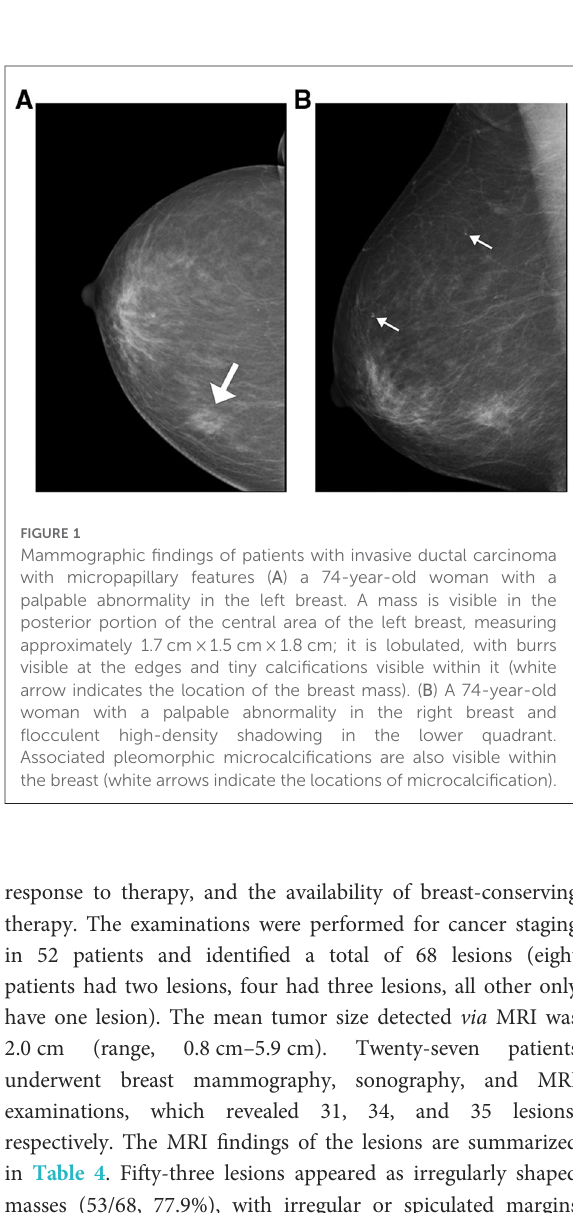
( Figure 5 ). Final pathological examination con fi rmed that eight patients had positive metastatic lymph nodes. No